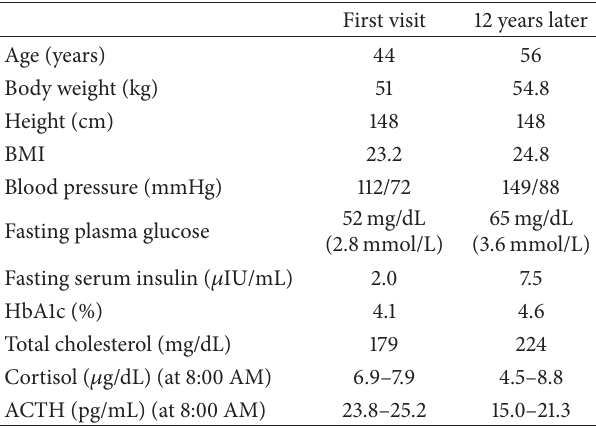
Table 1: Data of the